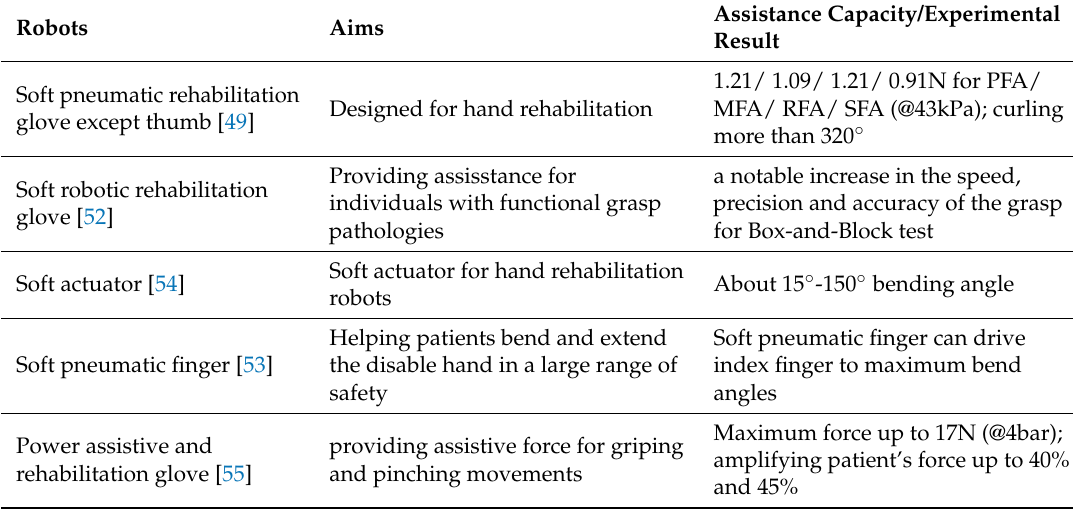
Table 2. Overview of soft rehabilitation and nursing-care robots based on soft intelligent